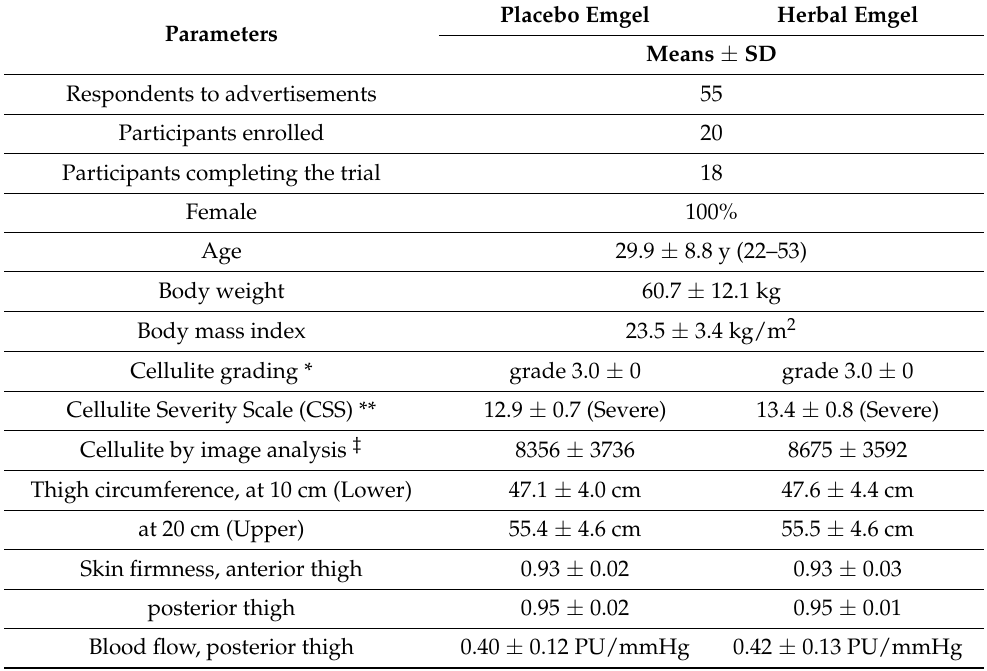
Figure 2. Participant experience through the trial. Table 1. Baseline